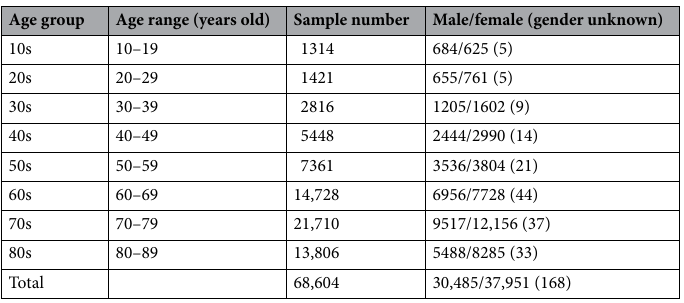
Table 1. Age and gender distributions of Holter acceleration